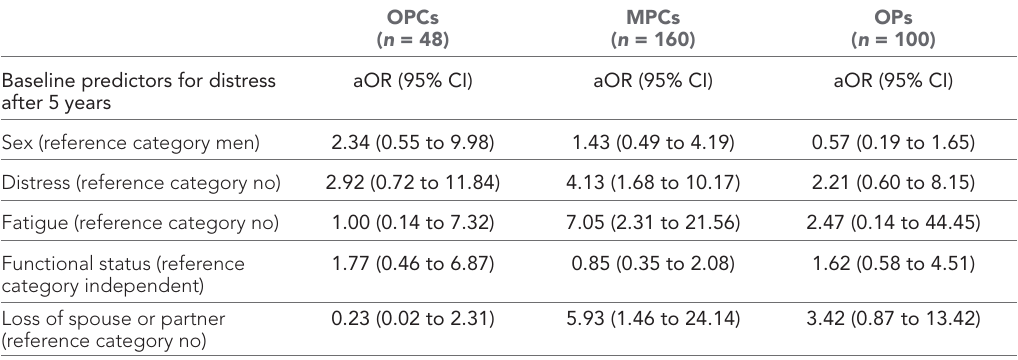
Table 4 Complete case analysis: multivariable logistic regression model with predictors for distress after 5 years, per patient group